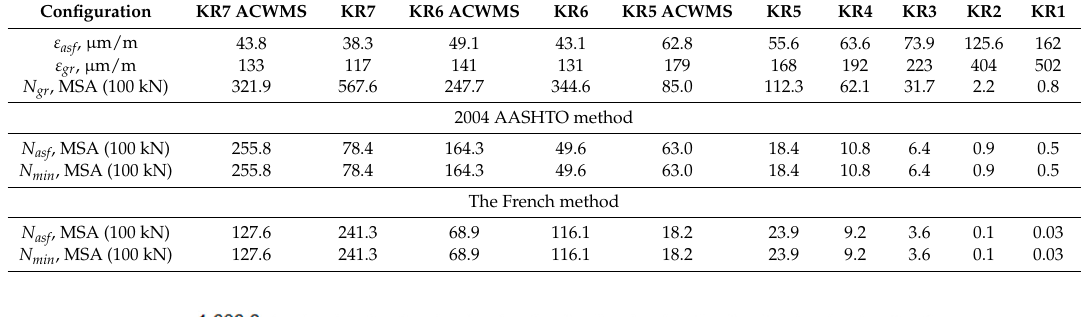
Table 5. The results of calculations of design life of the structures (stiffness of the asphalt layers according to laboratory tests).